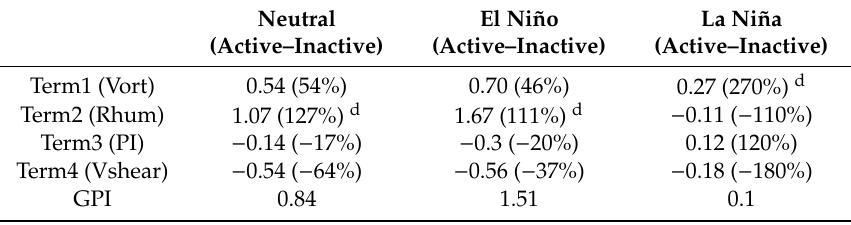
Table 3. Relative contributions to the GPI anomaly changes between the active and inactive MJO phases of Vort, Rhum, PI, and Vshear over the WNP for di ff erent ENSO conditions during June–November over the period of